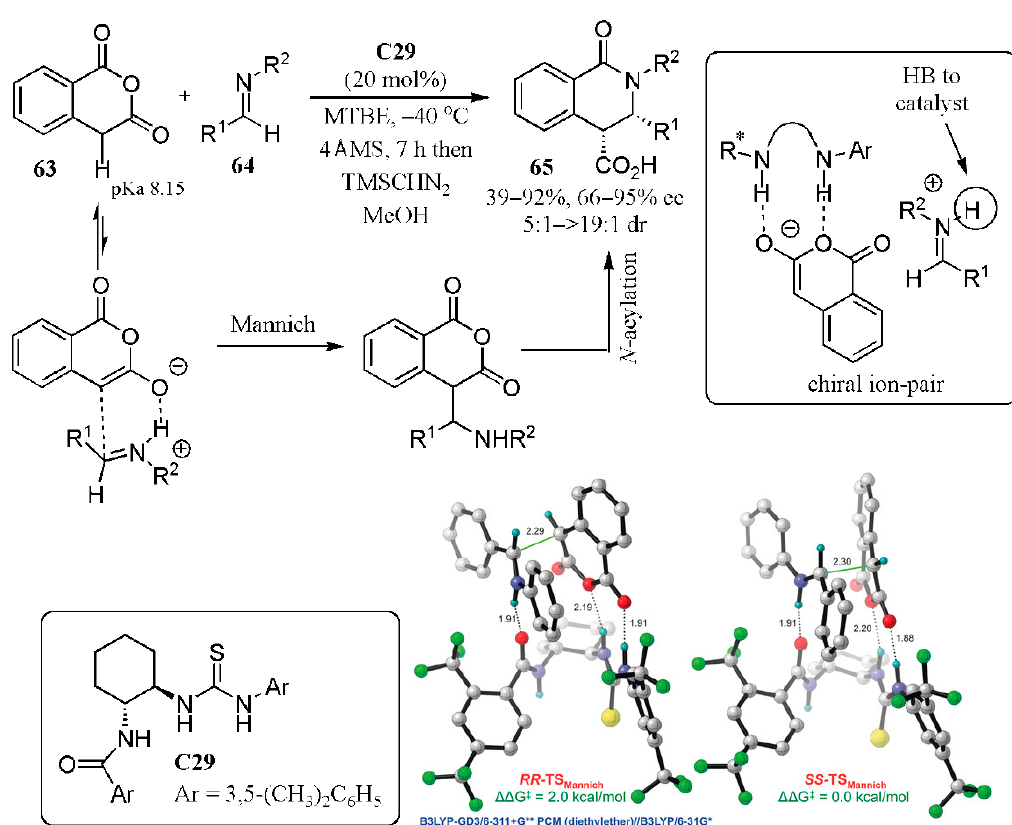
Figure 37. Enantioselective synthesis of lactams by [4 + 2] cycloadditions catalyzed by C29, including the lowest-energy transition structures leading to the major and minor enantiomers of product 65a ( 65 , R 1 =R 2 =Ph). Distances are in Å, and some hydrogen atoms are omitted for clarity [74]. Reprinted and adapted from Angewandte Chemie International Edition with permission from Wiley.